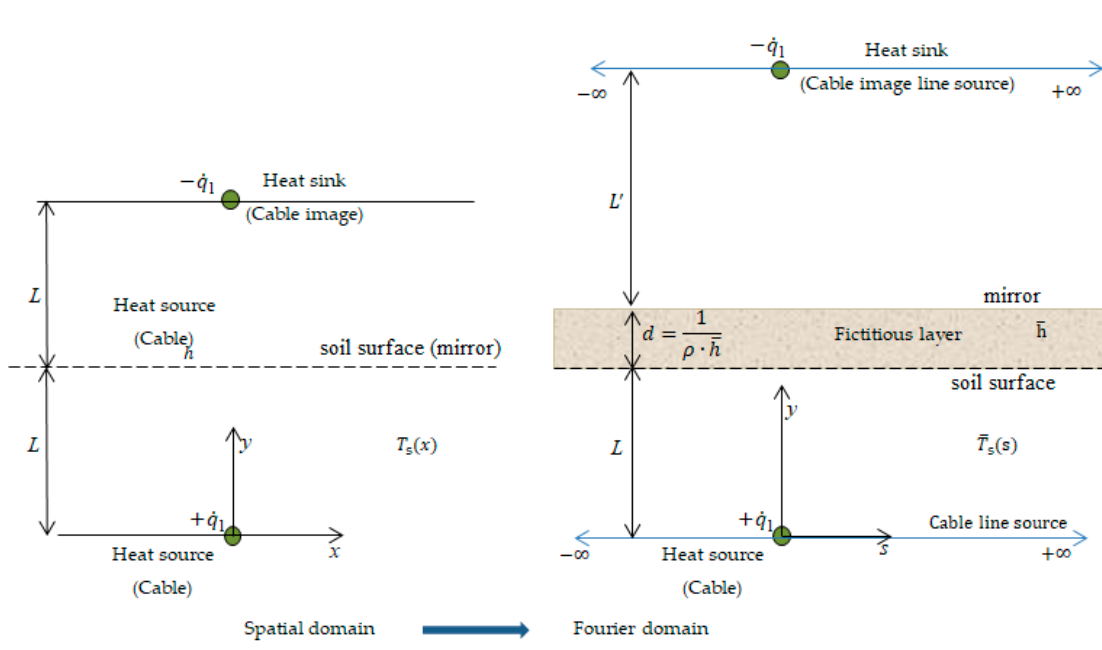
Figure 2. Adaptation of the image method for a non-isothermal ground surface.